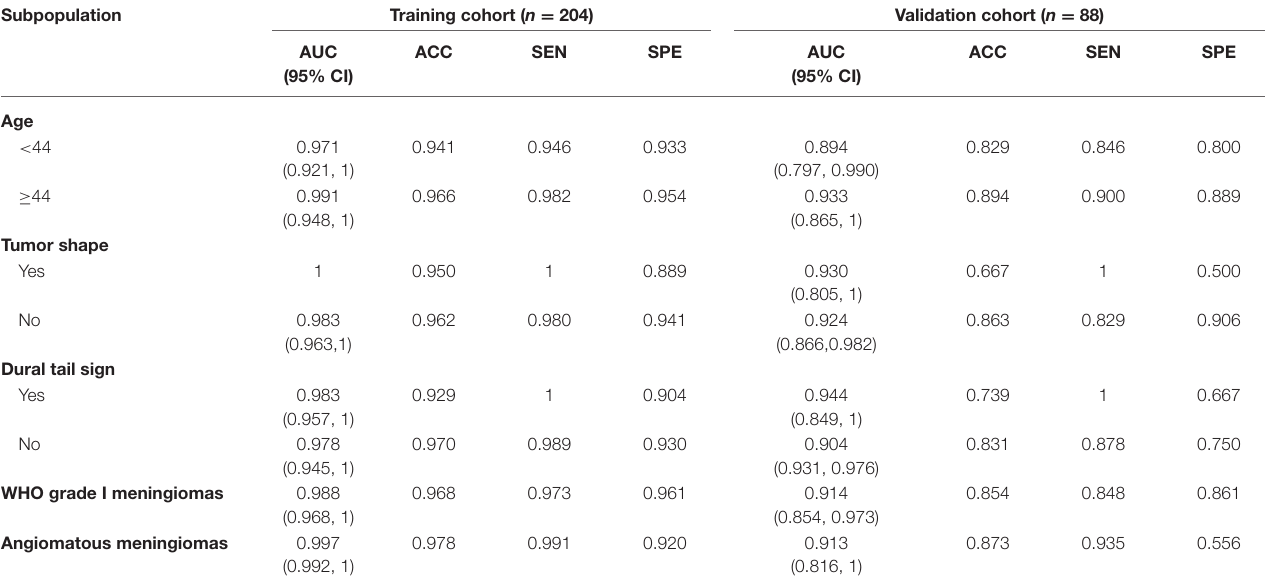
TABLE 3 | Stratification analysis of HMDT on training and validation cohorts.